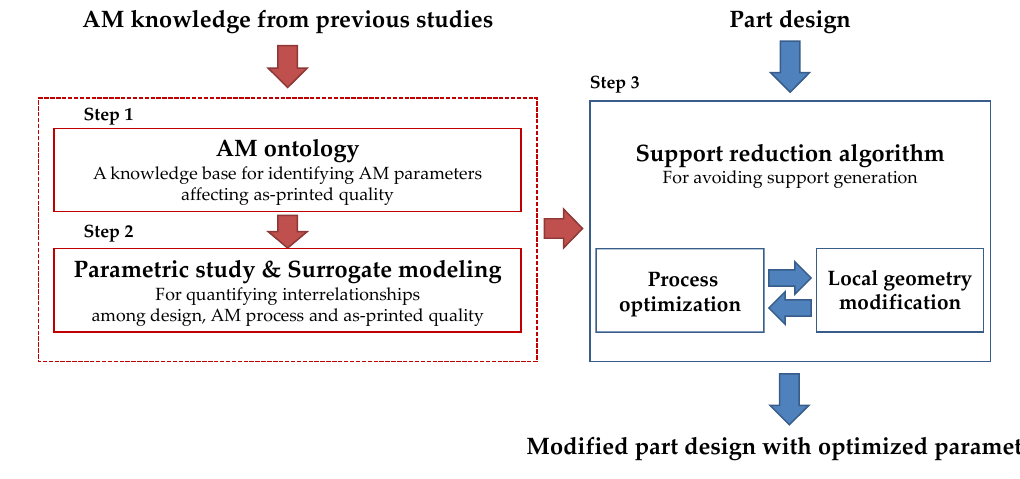
Figure 1. Overview of the proposed method.